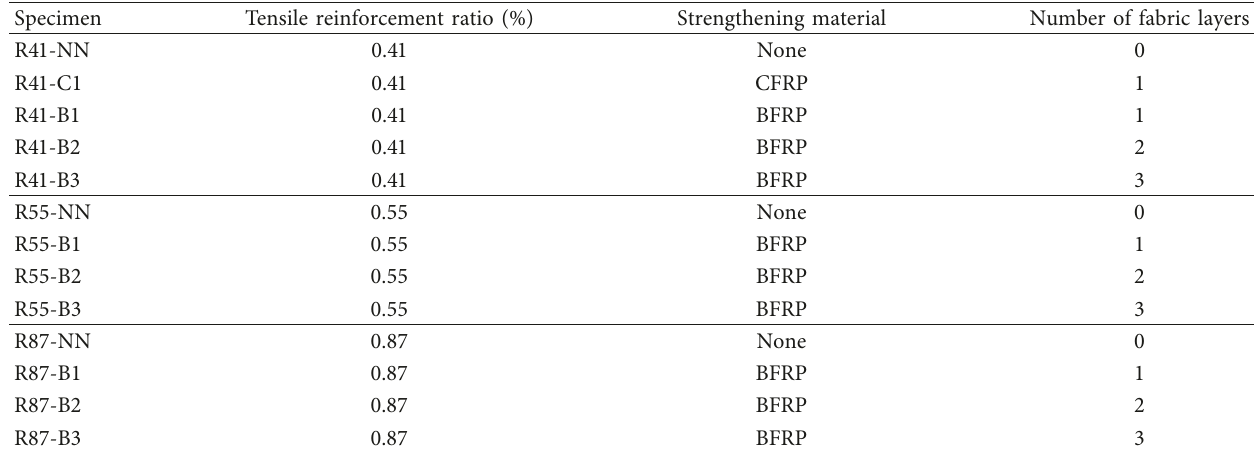
Table 4: Test parameter